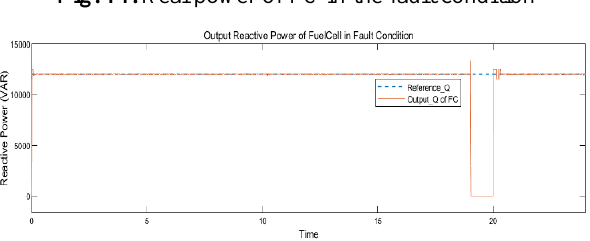
Fig. 14. Real power of FC in the fault condition